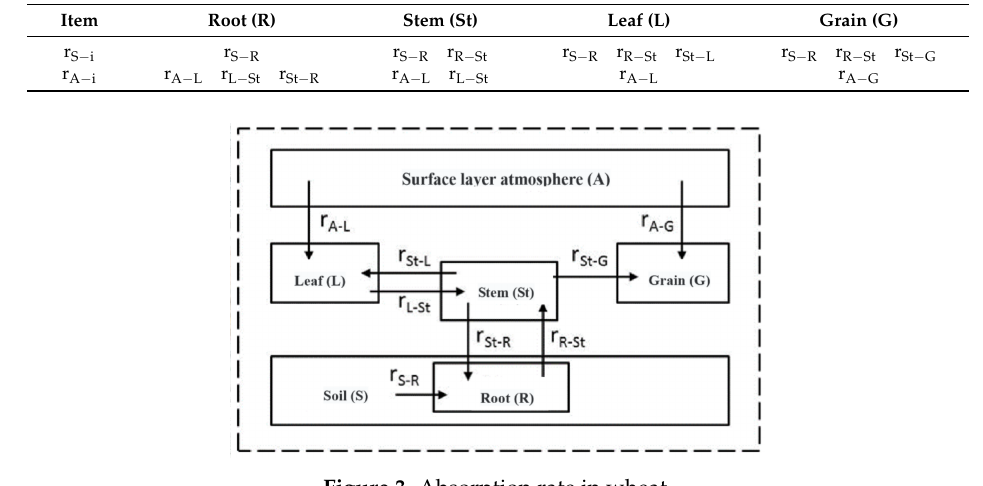
Table 1. Absorption rate formulas for trace metals in each part of wheat.